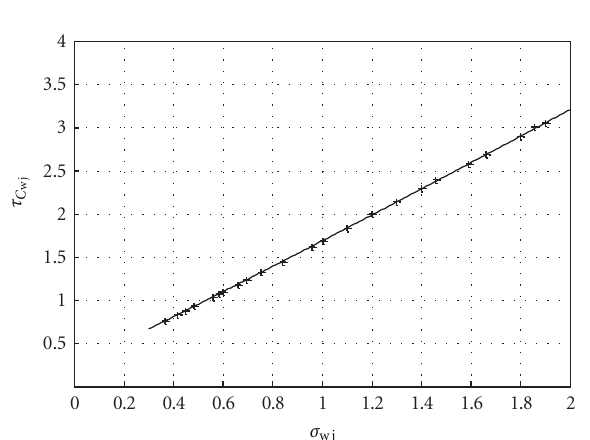
curve fitting. wj